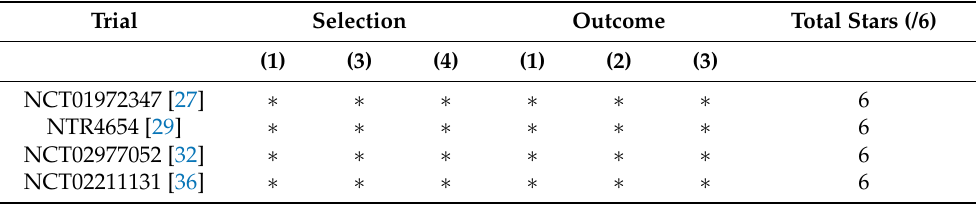
Table A2. Newcastle-Ottawa quality assessment scale for single-arm